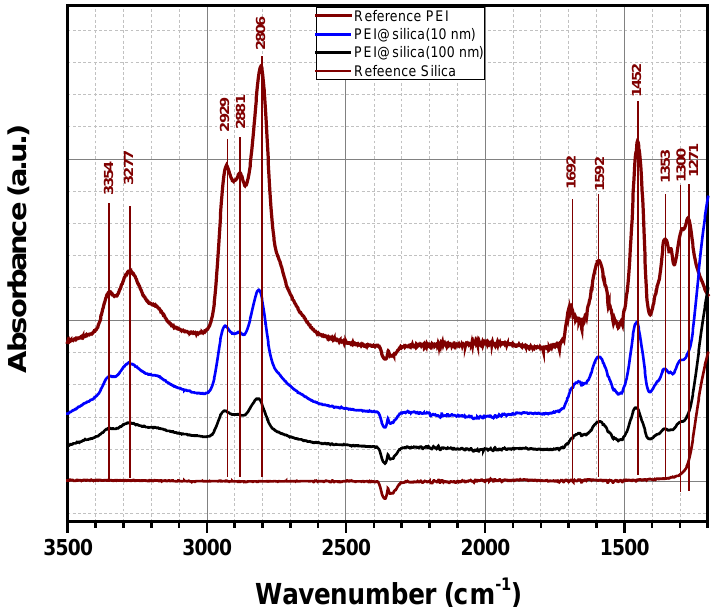
Figure 4. Absorbance spectra of pure PEI, pure silica and PEI@silica hybrid organic–inorganic materials.